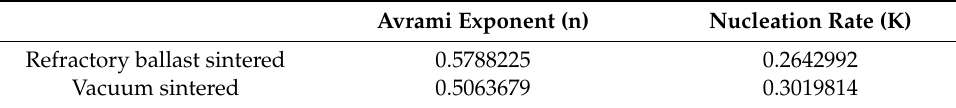
Table 2. Resulting n and K values used for the JMAK